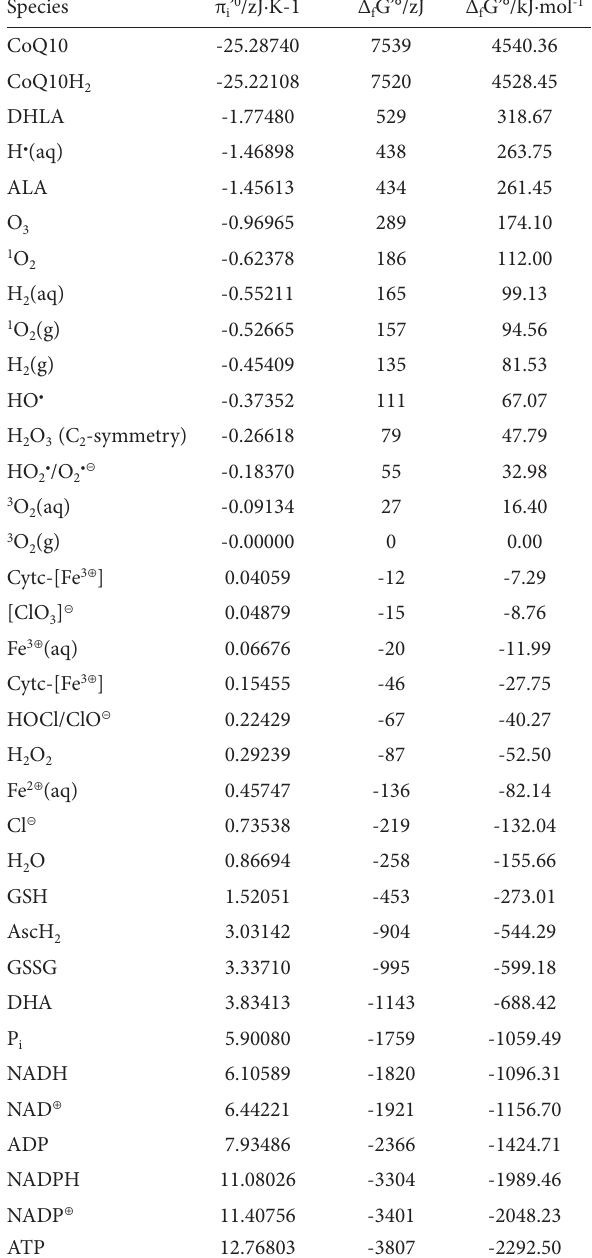
Table 1. Irreversibility potentials π i ’° and corresponding standard free energies of formation ∆ f G’° for chemical species considered in this work. Values computed at T = 398.15 K, pH = 7 for an ionic strength I = 0.25